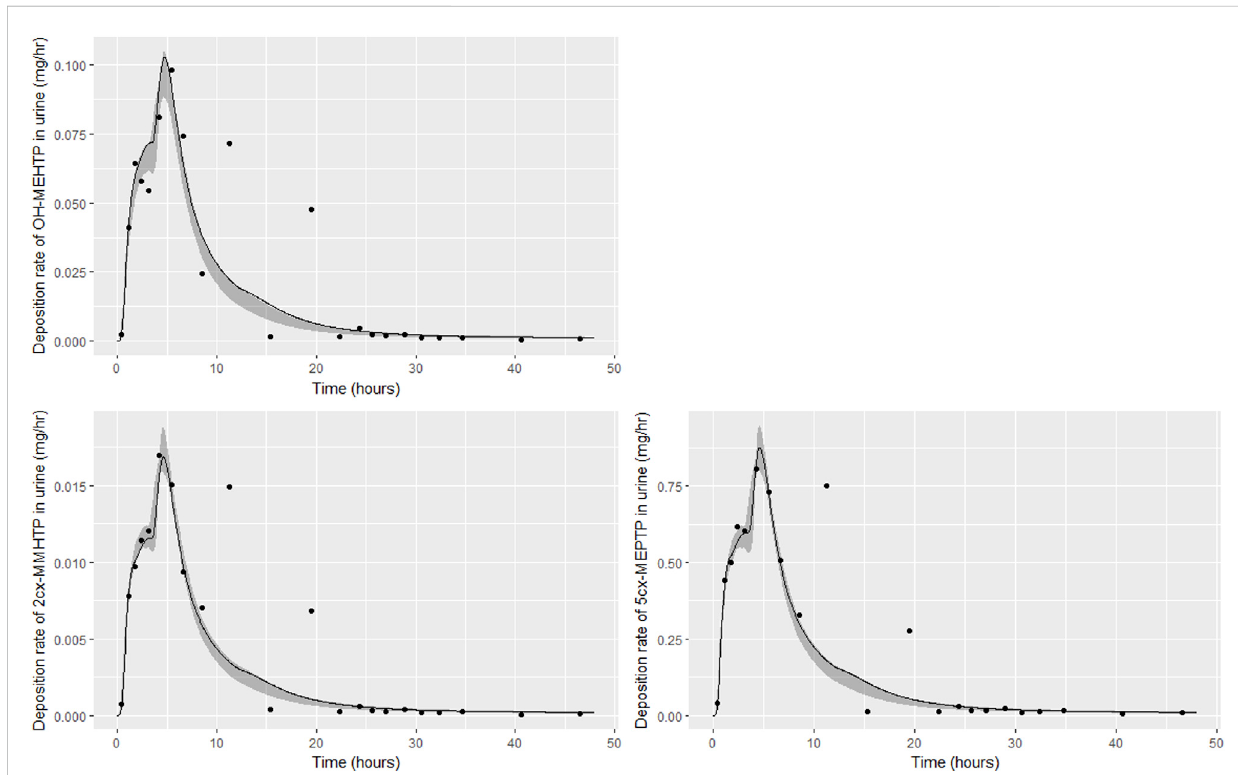
FIGURE 4 Fitofthecalibratedmodeltourinaryexcretiondatafromindividual (A) .Panel (A) OH-MEHTP(mg/h); (B) 2cx-MMHTP(mg/h); (C) 5cx-MEPTP(mg/h). The central estimates indicated in plots correspond to the posterior mode whereas the shaded regions represent 95% intervals for the respective